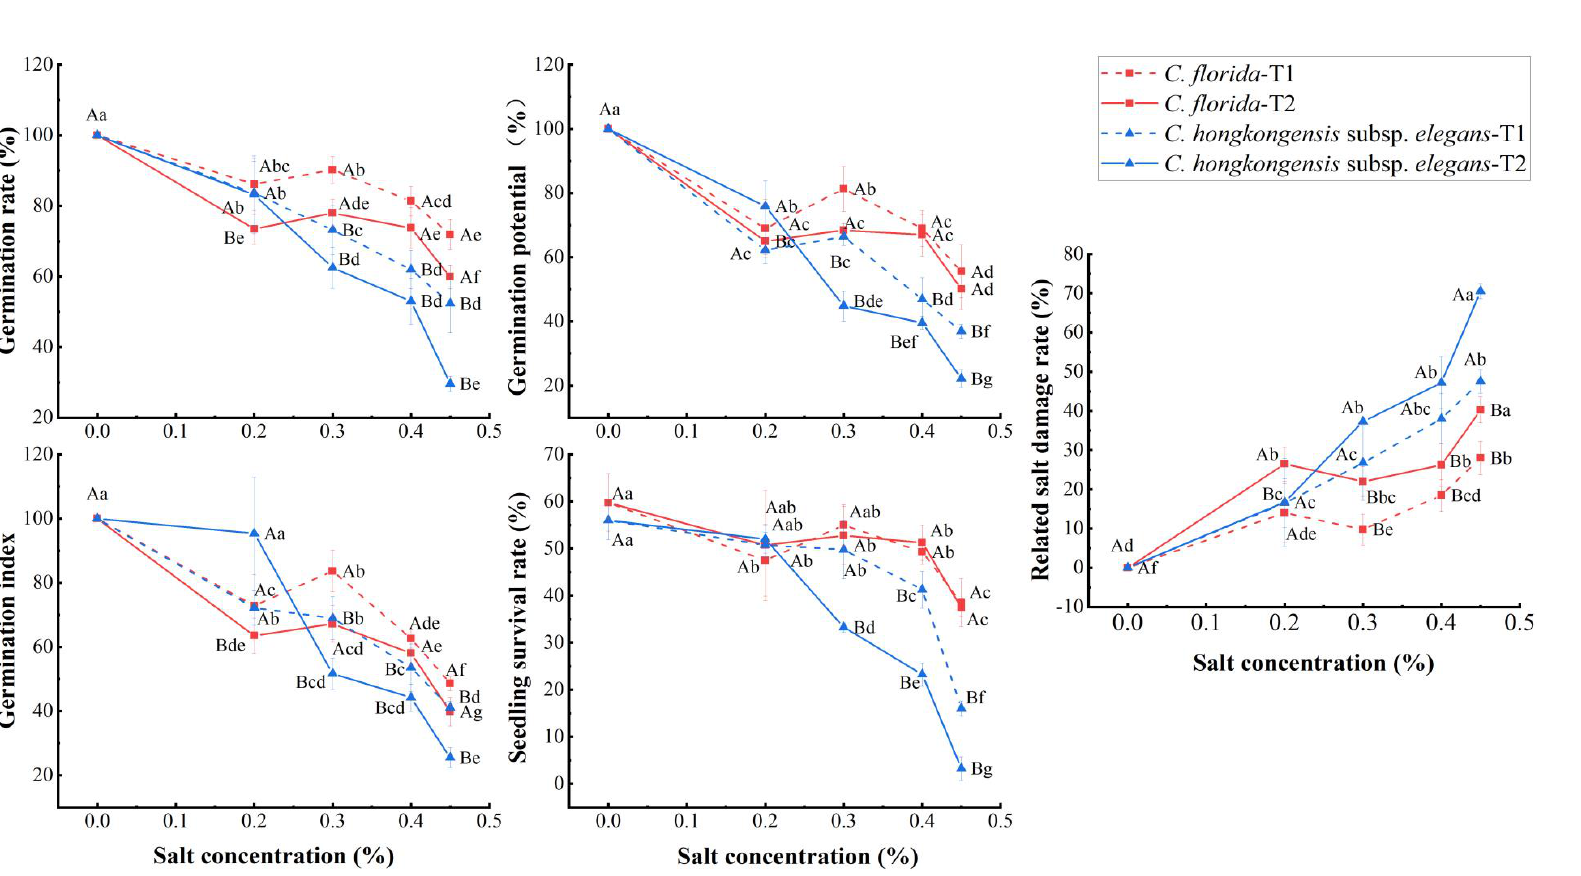
Figure 1. Effects of different treatments on germination parameters (germination rate (GR), germination potential (GP), germination index (GI), related salt damage rate (SDR)), and seedling survival rate (SR) of Cornus florida and Cornus hongkongensis subsp . elegans. Values are means of 4 independent replicates ± standard error. Different uppercase letters indicate the significant difference between species in the same treatment, and different lowercase letters indicate the significant difference among treatments for the same species according to Duncan’s new multiple range test ( p < 0.05). Meanwhile, germination parameters of CK were transformed to 100% (relative germination parameters), while those of salt treatments are expressed as relative germination parameters, which were calculated by multiplying the mean percentage increase in the relative germination parameters of CK compared with the absolute germination parameters.